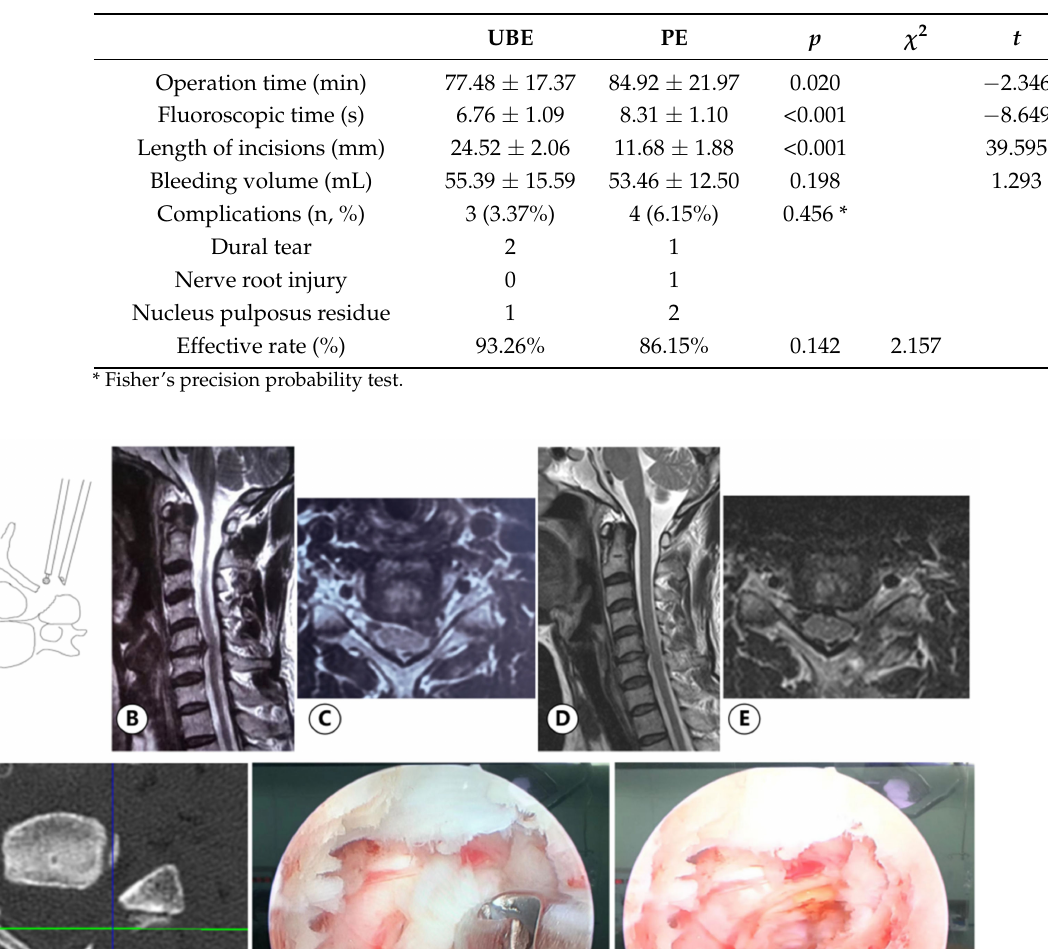
Table 2. Surgical Data.